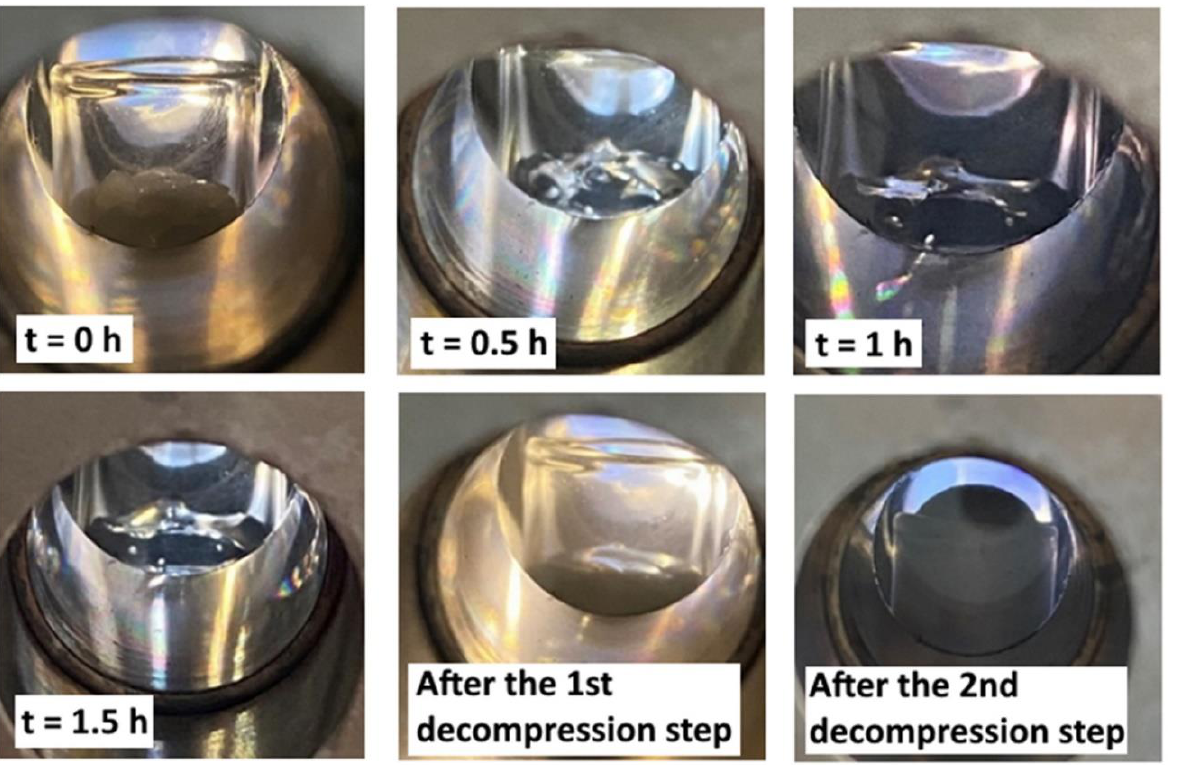
Figure 4. Progression of the sc-CO 2 assisted foaming of pure PCL at 50 °C and using a two-step decompression.